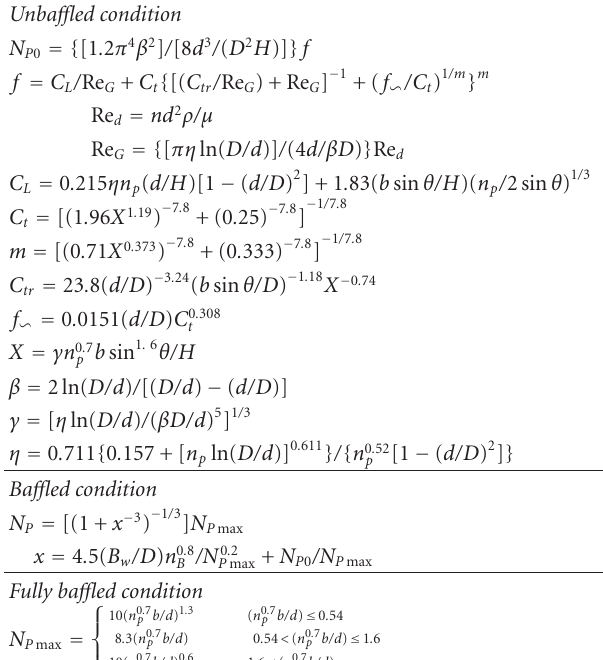
Table 1: Correlation equations of power number for paddle (a), Rushton turbine (c) and anchor (f). Unba ffl ed condition